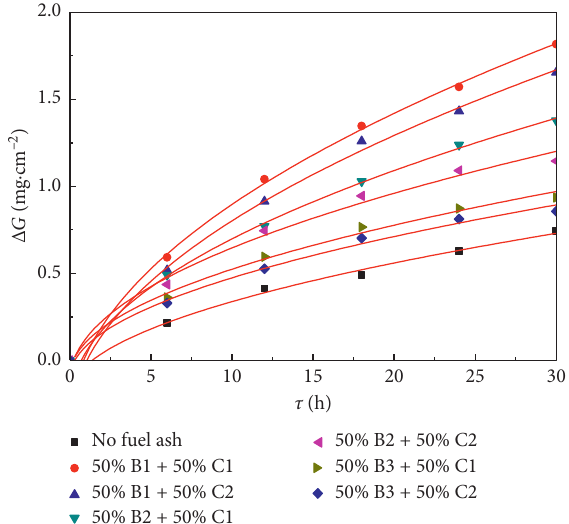
Figure 2: Curves of corrosion mass gain of different metal samples coated with different fuel